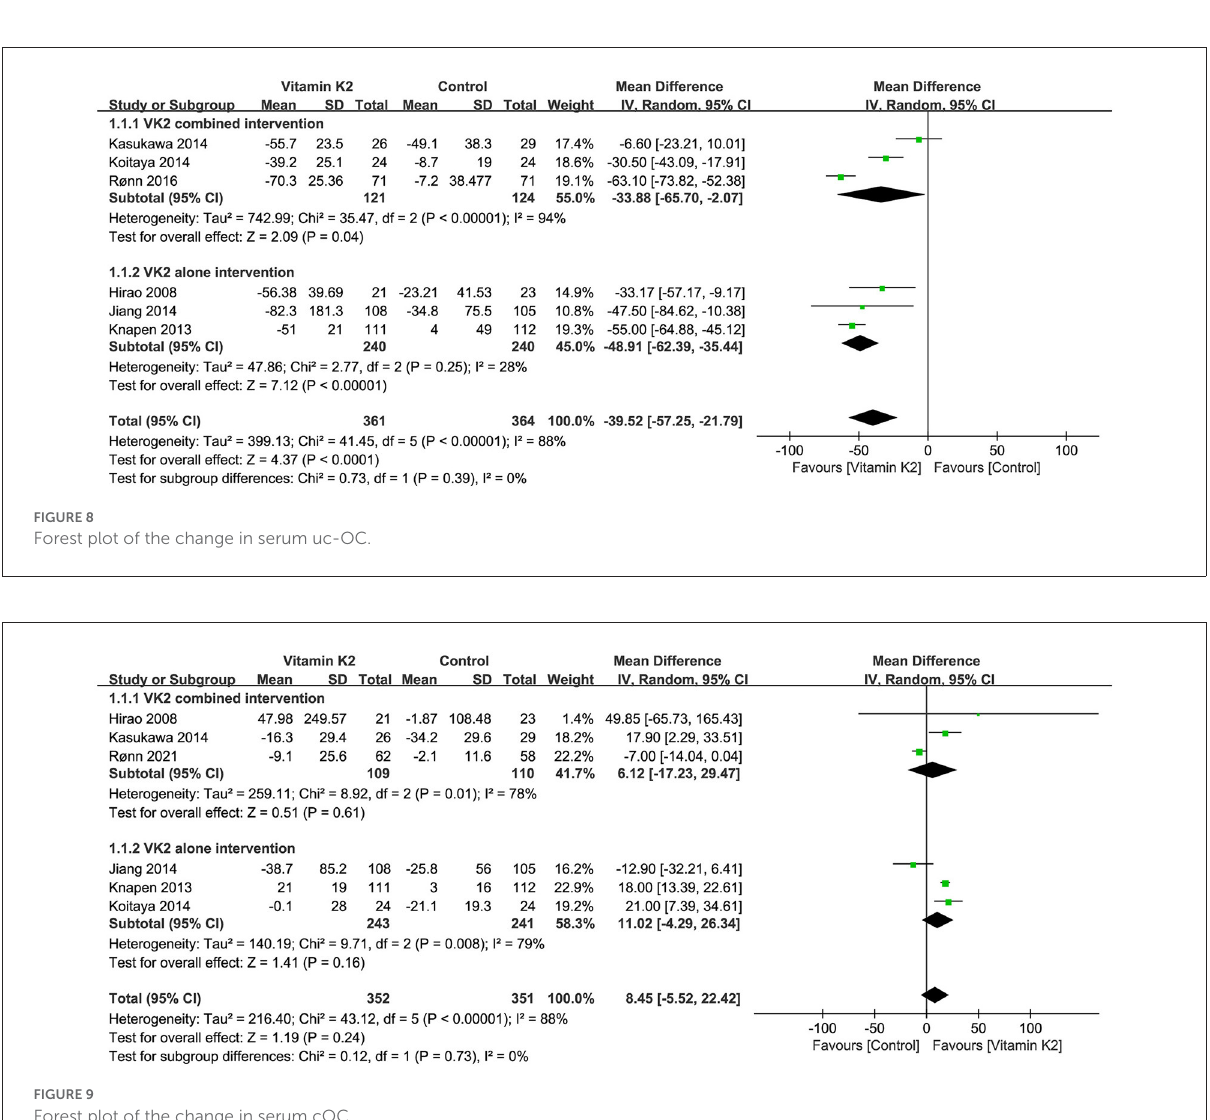
FIGURE9 Forest plot of the change in serum